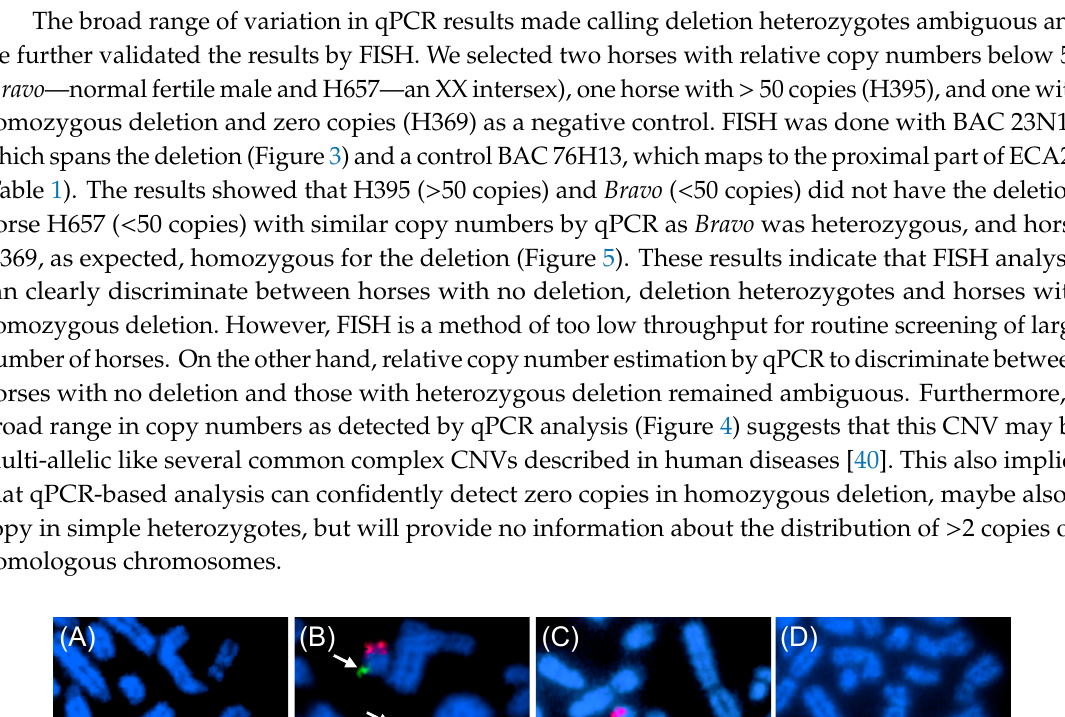
Table 3. Frequency of deletion homozygotes among horses with DSDs and/or fertility problems. Phenotype